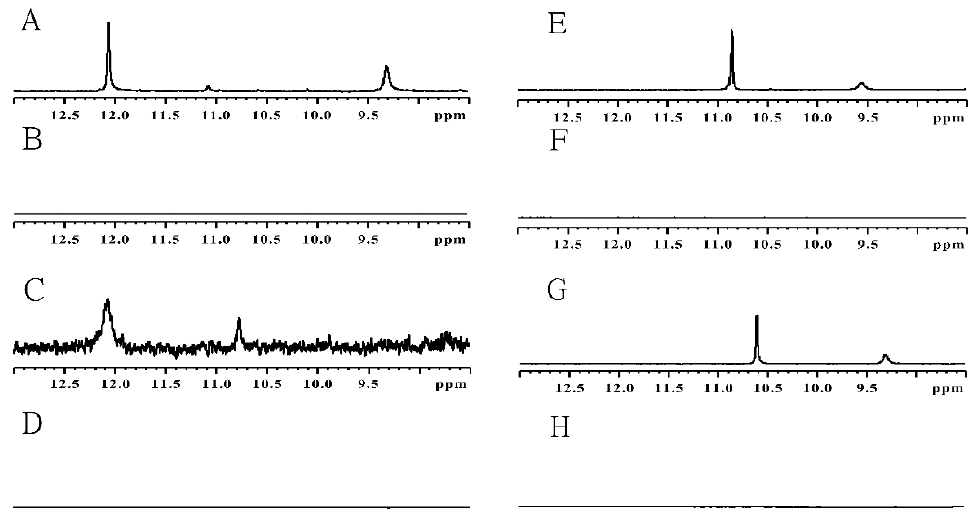
Figure 4. 1 H NMR spectra of UAs: C-2028 at pH = 1 ( A ) and pH = 7 ( B ), C-2041 at pH = 1 ( C ) and pH = 7 ( D ), C-2045 at pH = 1 ( E ) and pH = 7 ( F ), C-2053 at pH = 1 ( G ) and pH = 7 ( H ). Temperature = 5° C; H 2 O/D 2 O collected in 10 −2 M cacodylate buffer.